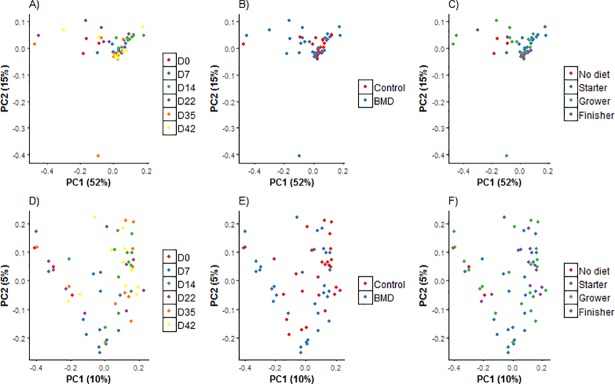
Principal coordinate analysis (PCoA) based show weighted (based on abundance; A-C) and unweighted (based on presence/ absence; D-F) pairwise UniFrac distances between samples of ileum microbial community with respect of age (d0, 7, 14, 22, 35 and 42), treatment (BMD-supplemented and BMD-free (control) and diet (no diet: d0 birds fed no diet, starter (fed from d0-22), grower (d23-d35) and finisher (d35-42).